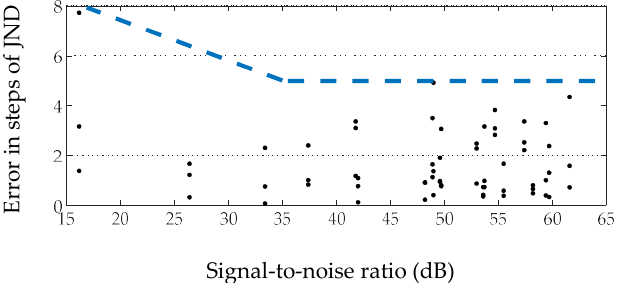
Figure 14. EDT parameter value errors measured with a handclap (compared to measurements with a dodecahedron) in steps of JND as a function of the signal-to-noise ratio for di ff erent octave bands. The dashed line represents a threshold below which all JND values were measured.